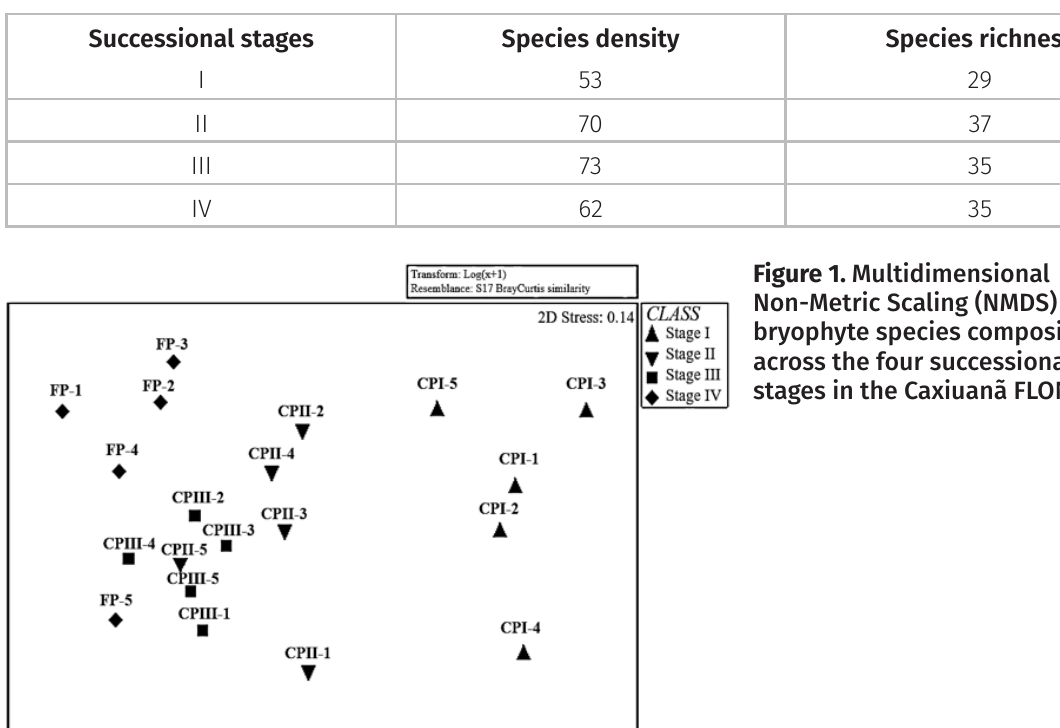
Table II. Mean density and richness of bryophyte species per plot across successional stages in the Caxiuanã FLONA, Pará, Brazil.